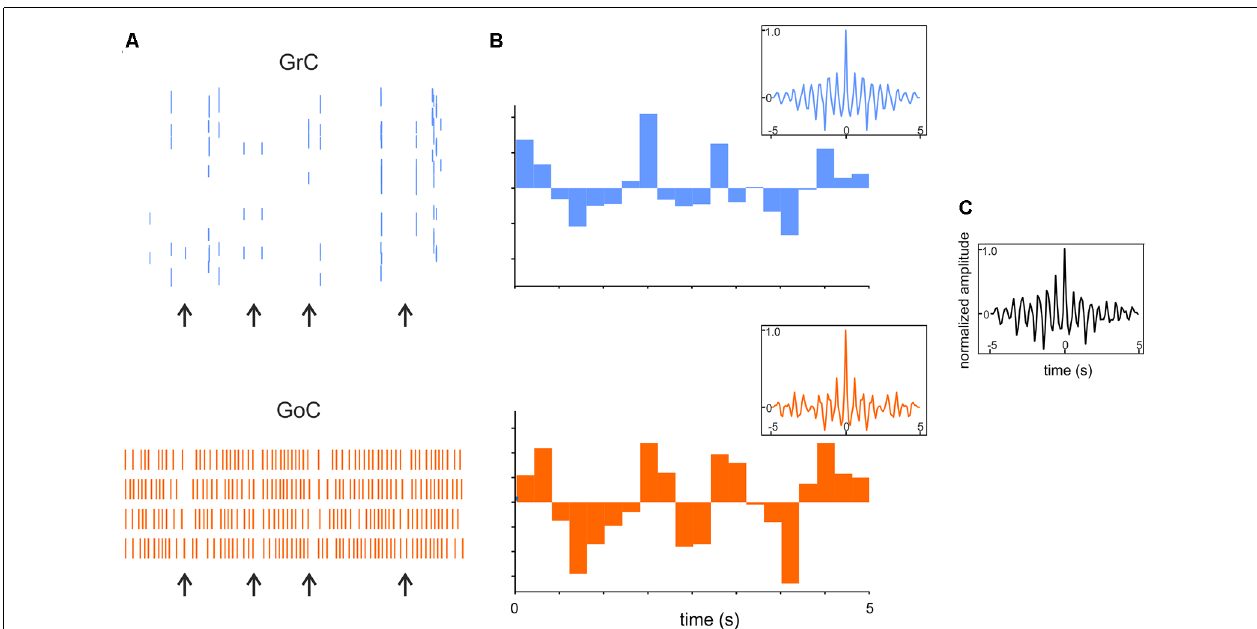
FIGURE 8 | Synchronous low-frequency oscillations in the GL revealed by computational modeling. (A) Raster plots of representative GrC and GoC during 5 Hz random MF input. Note that synchronous patterns are visible (arrows). (B) Cumulative PSTH of the whole GrCs and GoCs population. Insets show the autocorrelograms of the activity in corresponding population. (C) Crosscorrelogram of GrC and GoC populations activity. Adapted from Casali et al.